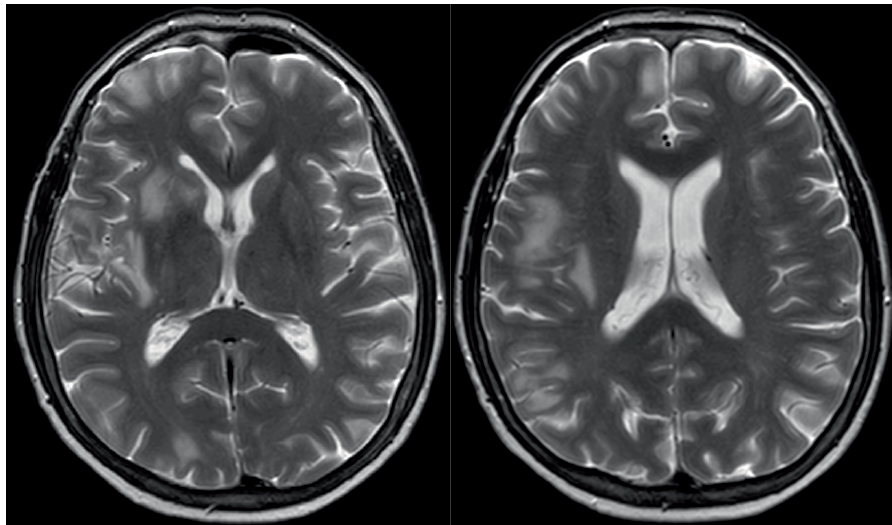
Figure 1: Transversal T2-weighted MR images five months after endovascular treatment show high-signal white matter changes with slight mass effect in the vascular territory of the right internal carotid